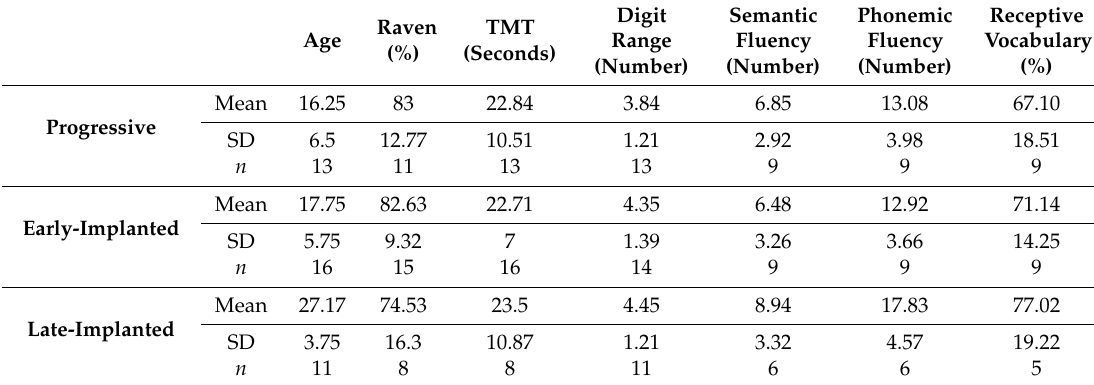
Table 2. Mean age and scores in the linguistic and cognitive tests for the early-implanted, late-implanted, and progressive CI